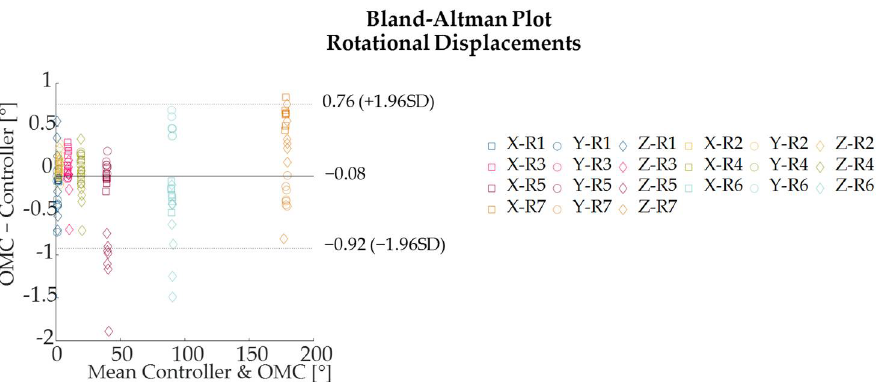
Figure 11. Bland–Altman plots comparing the rotational displacements measured by the Qualisys Optical Motion Capture (OMC) system and by the Controller A of the Oculus Quest 2.